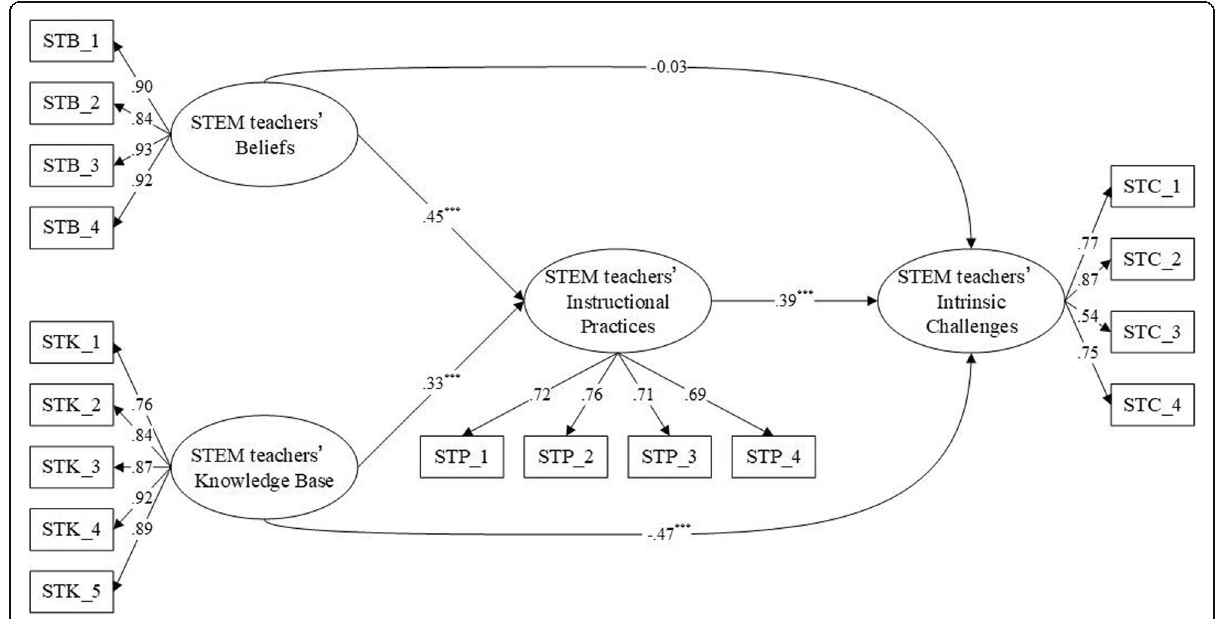
Fig. 2 Path analysis diagram and standardized path coefficients of the scale